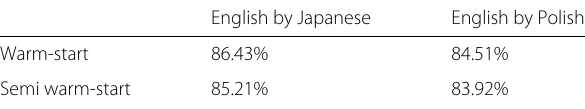
Table 4 Results of conducted experiments for setup 3